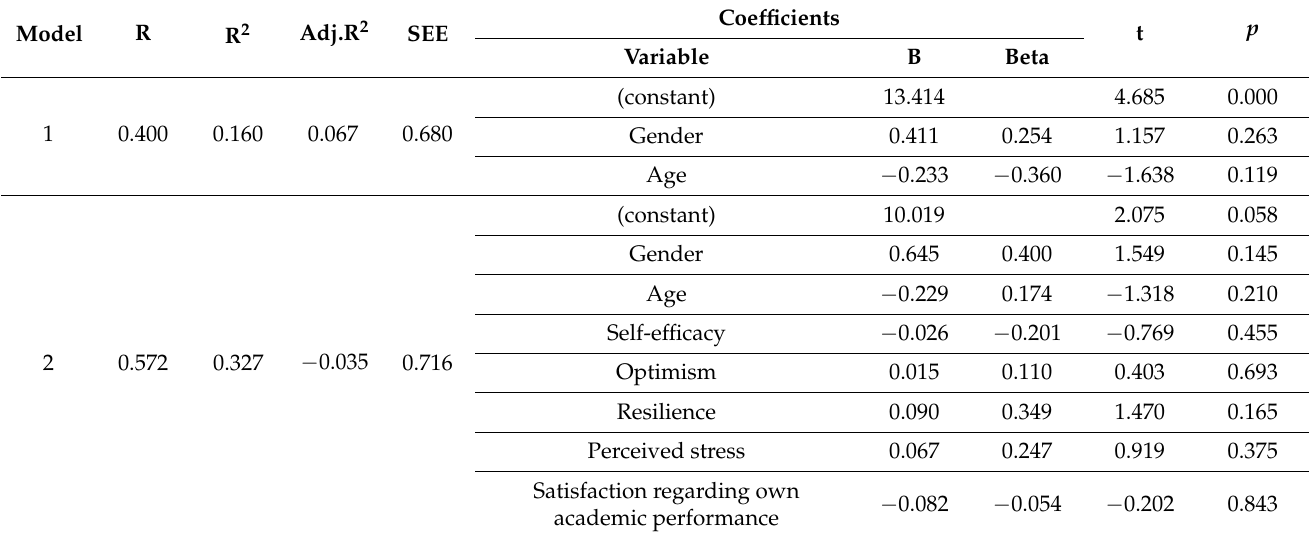
Table 4. Determinants of academic performance for preclinical students. ( N = 21) (linear regression). Model